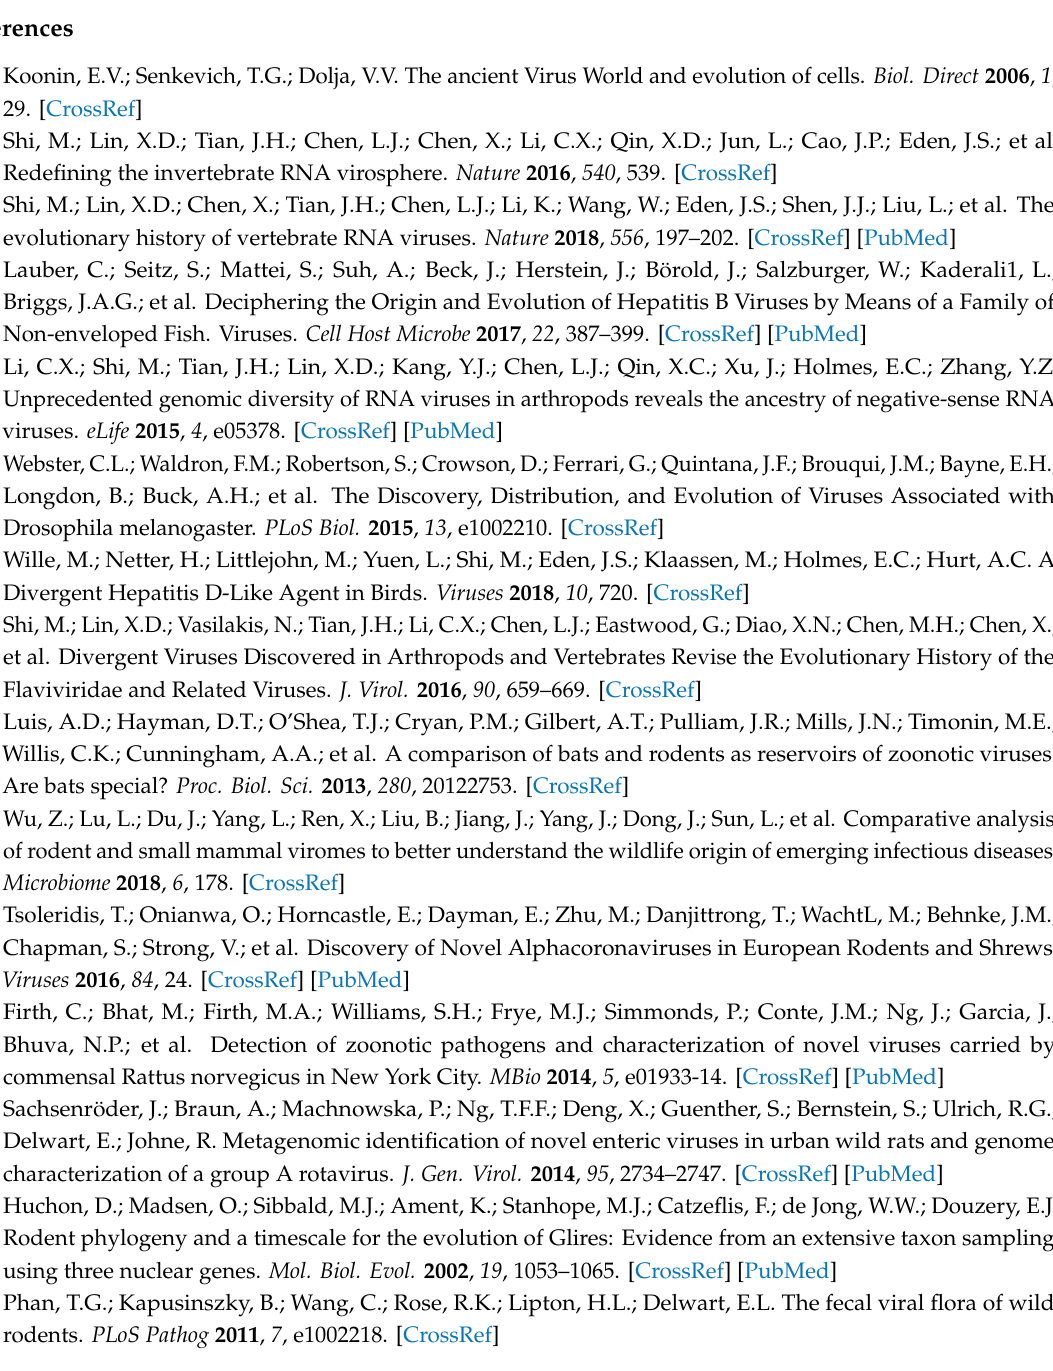
Phylogenetic relationships of the field vole paramyxovirus based on the M , N and P genes, Figure S3: Phylogenetic relationships of the field vole and the rabbit rotavirus A based on the VP1, VP2 and VP3 segments, Figure S4: Phylogenetic relationships of the field vole and the rabbit rotavirus A based on the VP6, VP7 and NSP2 segments, Figure S5: Phylogenetic relationships of the novel field vole astrovirus based on the ORF1a , ORF1b and capsid genes. Author Contributions: T.T., C.P.M. and J.K.B. conceived and designed the experiments; T.T., J.G.C., C.P.M., E.M.-L. and G.U. performed the experiments; E.M.-L., G.U., R.E.T. and M.B. provided samples; T.T., M.S., E.C.H. and J.K.B. analyzed the data. T.T., E.C.H. and J.K.B. wrote the paper; all authors edited the final draft. All authors have